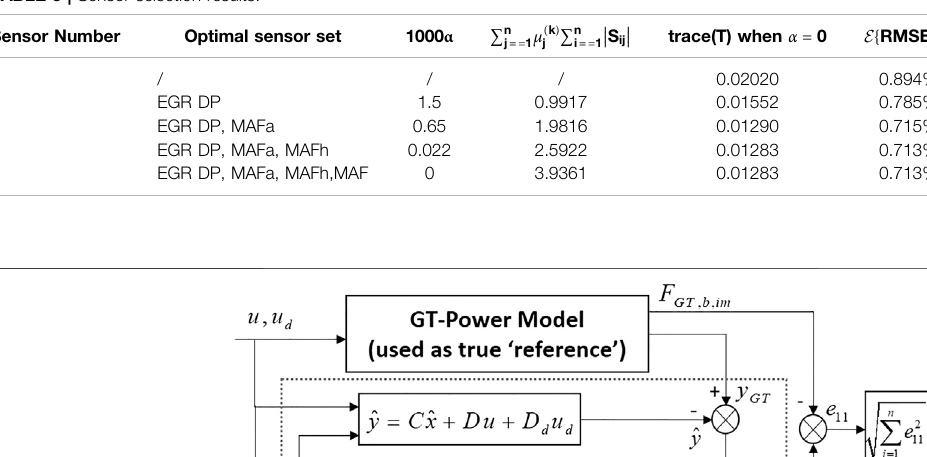
TABLE 5 | Sensor selection results.